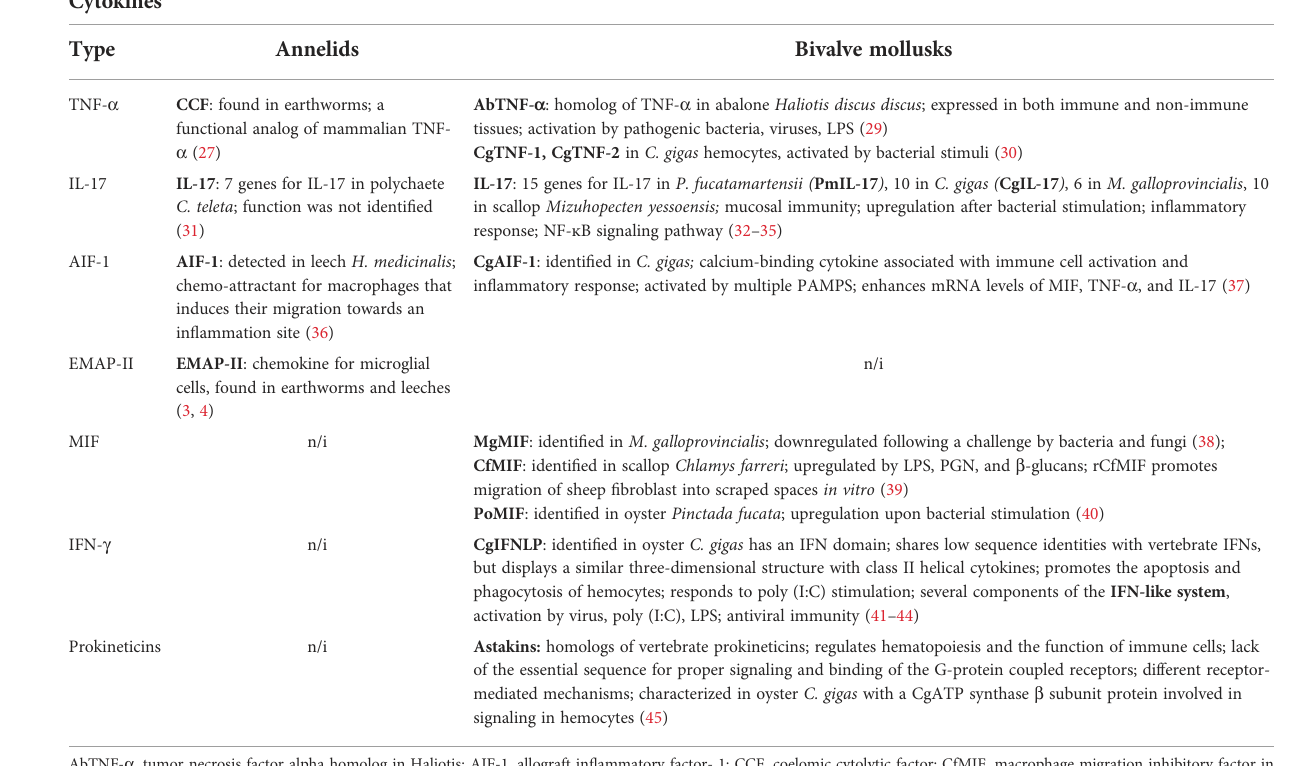
TABLE 2 Cytokines in annelids and bivalve